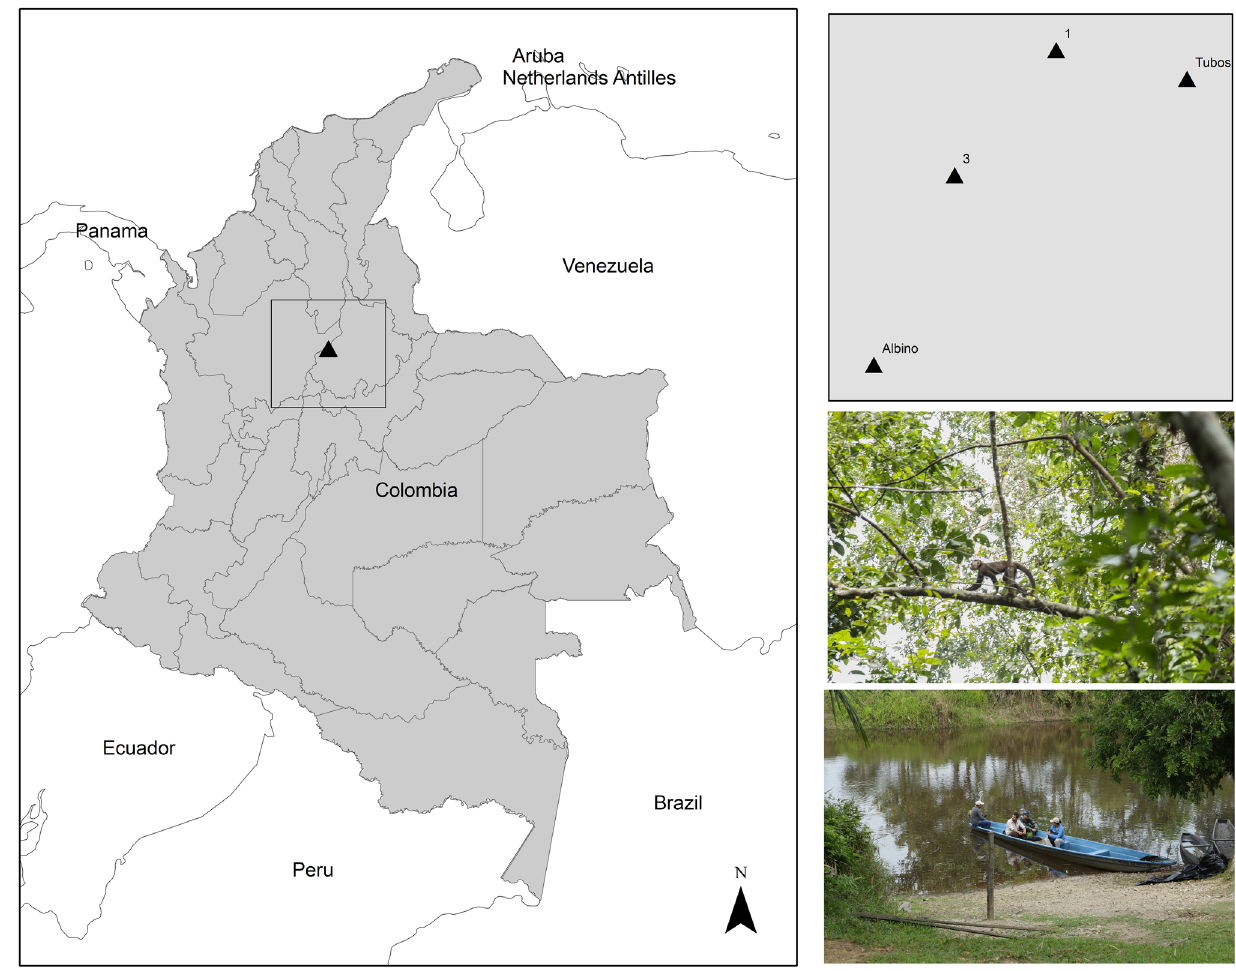
Figure 4. Map of the study site in San Juan Carare, Santander, Colombia, showing the location of transects within forest fragments and the nearest human settlement. The four tiangles show the distribution of the fragments sampled. The map was generated using ArcGis 10.7.1. (https:// deskt op. arcgis. com/ en/ arcmap/) Copyright 1995–2018 Esri. All rights reserved. Published in the United States of Blood-meal analysis. To detect vertebrate blood sources, we removed the abdomen from each engorged female mosquito with blood content greater than 60% and extracted nucleic acid with DNA/RNA MiniPrep Viral kit (Zymo, Inc.) following the manufacturer’s instructions. We used conventional PCR with universal primers for the amplification of a region of the mitochondrial cytochrome b (Cytb) gene of birds and mammals 58,59 . For samples that did not amplify, we used primers for amplifying a region of the mitochondrial COI gene 2 . PCR was performed in a reaction containing 12.5 μL of 2 × GoTaq Green Master Mix® (Promega), 5 μM of each primer and 2.5 μL of DNA. The amplification products were visualized on agarose gels, and positive sam- ples were sequenced by capillary electrophoresis (the Sanger method) using an ABI-3500 genetic analyzer from Life Technologies (3500 Genetic Analyzer) at the Gencore Laboratory. We edited the raw sequences using the